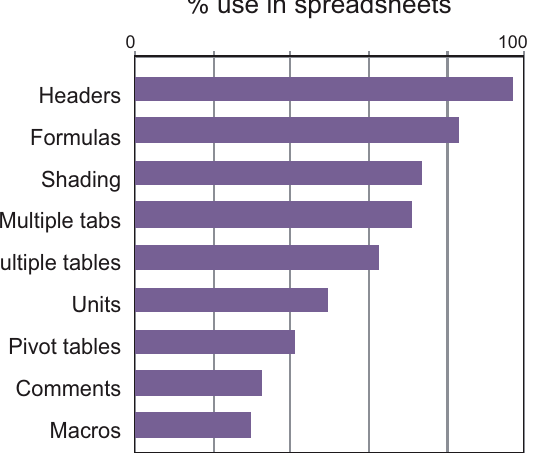
Figure 5. Percent of researchers surveyed that reported a given feature as present in their Excel data. n = 70.